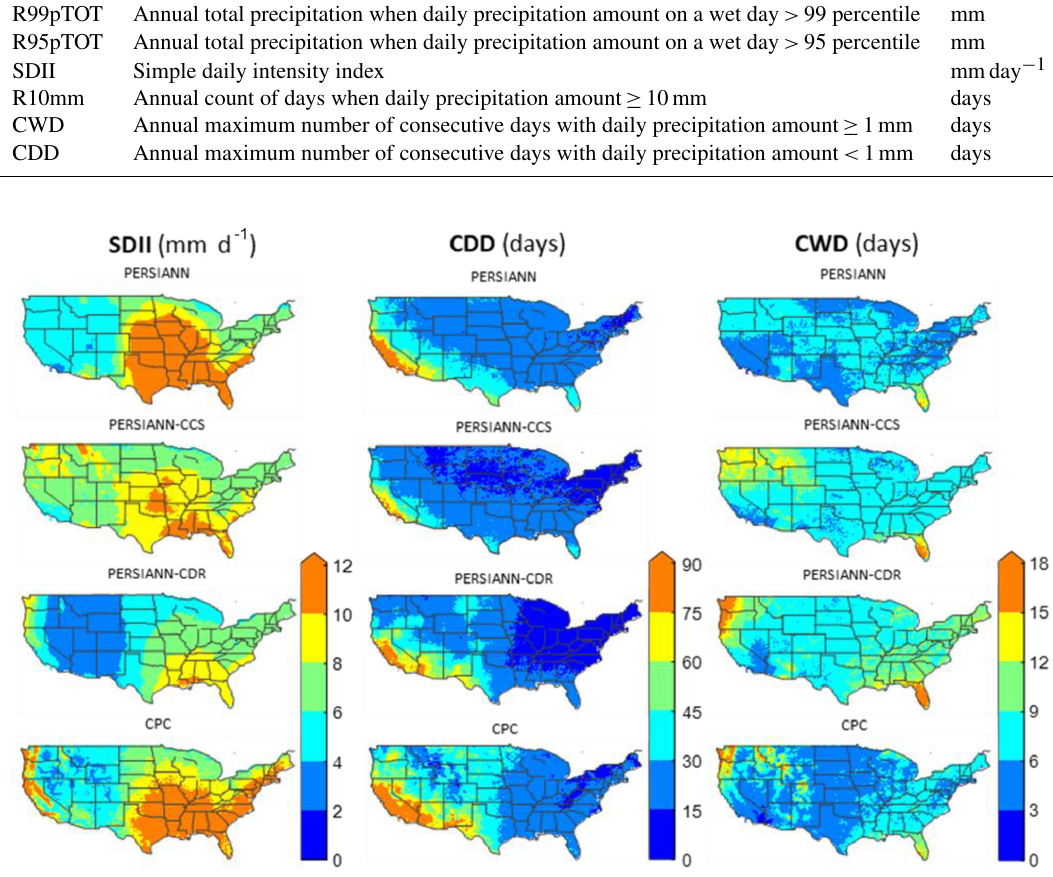
Figure 4. Extreme precipitation indices (SDII, CDD, and CWD) for PERSIANN, PERSIANN-CCS, and PERSIANN-CDR over the CONUS (see Table 4 for definitions of the